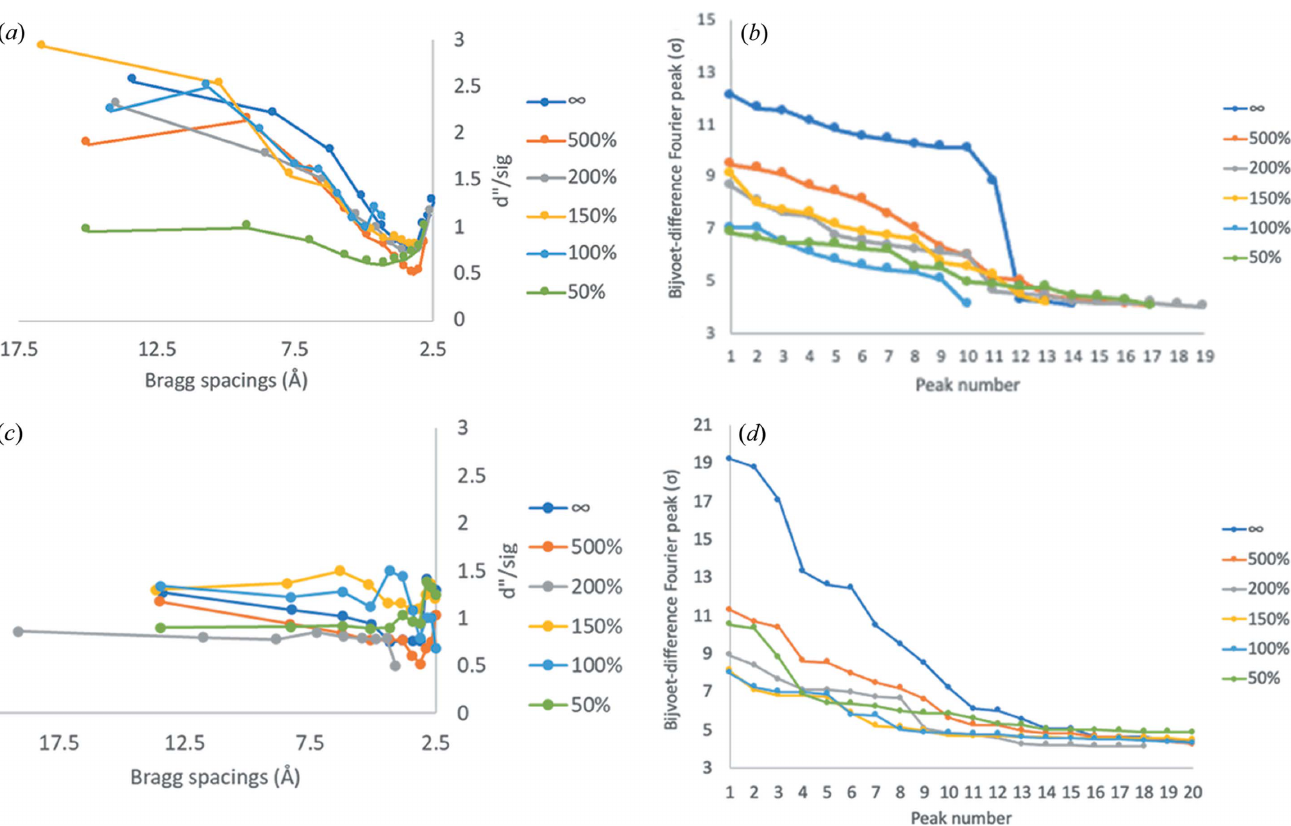
Figure 6 Analysis of assembled 15-crystal thaumatin data and 18-crystal TehA data. ( a ) Plot of d 00 /sig with respect to d min . SHELXC was used for calculation of the anomalous signal from 15 assembled thaumatin crystals with and without frame rejection. ( b ) Plot of the 19 highest Bijvoet-difference Fourier peaks of thaumatin. Total frames, 18900; rejected frame numbers: 500%, 425; 200%, 7388; 150%, 9152; 100%, 11370; 50%, 14796. ( c ) Plot of d 00 /sig with respect to d min . SHELXC was used for the calculation of anomalous signals from 18 assembled TehA crystals with and without frame rejection. ( d ) Plot of the 20 highest Bijvoet-difference Fourier peaks of TehA. Total frames, 24480; rejected frame numbers: 500%, 285; 200%, 2538; 150%, 4897; 100%, 9424; 50%, 15338.